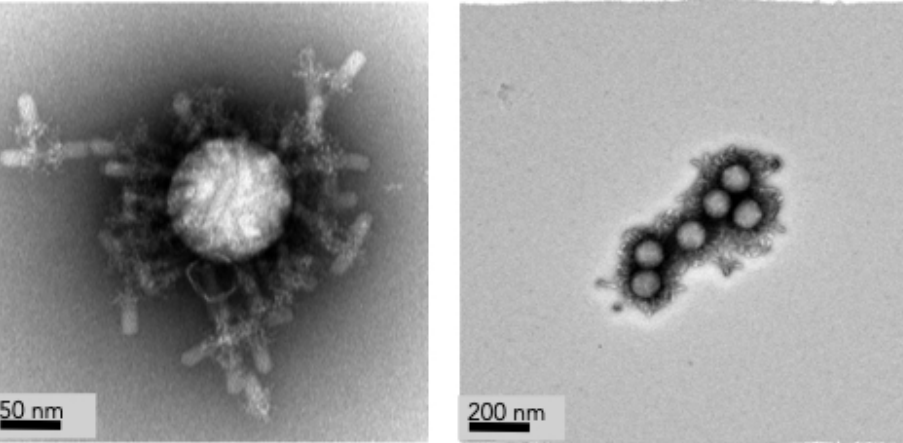
Figure 3. ( Left ) Single functionalized microsphere with multiple bound bacteriophage tails in random orientations. ( Right ) Multiple functionalized microspheres with attached bacteriophage tails. Micrographs take by Dr. James Conway, University of